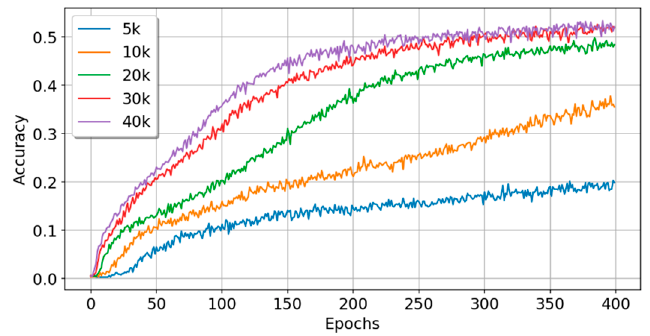
Figure 21. The performance of CNN for different size data.